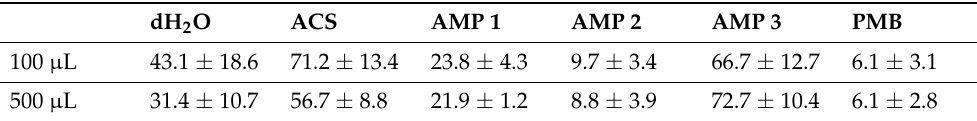
Figure 9. OD measurements at 405 nm (Y-axis) of free hemoglobin in a 1% human erythrocyte solution incubated with PBS, dH 2 O, ACS, Triton X-100, SDS, Tween, AMPs 1, 2, or 3 (100 µ M), or polymyxin B (100 µ M) for 60 min at 37 ◦ C using high (500 µ L: black bars) or low (100 µ L; red bars) volumes. Average values from three experimental replicates, each containing two technical replicates, are presented with error bars (SD) included in plots. Significantly different data as defined from paired t -test is indicated by asterisks ( p -values: * <0.05 ns: non-significant). Table 8. Calculated hemolysis ratios according to Equation (1) for dH 2 O, ACS, and AMPs 1, 2, and 3 (100 µ M) or polymyxin B (PMB–100 µ M) from measurements at 405 nm on 1% washed human erythrocytes. Total volumes during incubation were 100 or 500 µ L. Measurements from samples with 10% Triton X-100 (positive control) and PBS (negative control) were used as 100% and 0% hemolysis for the normalization. Normalization was performed on data averaged from three experimental replicates, each containing two technical